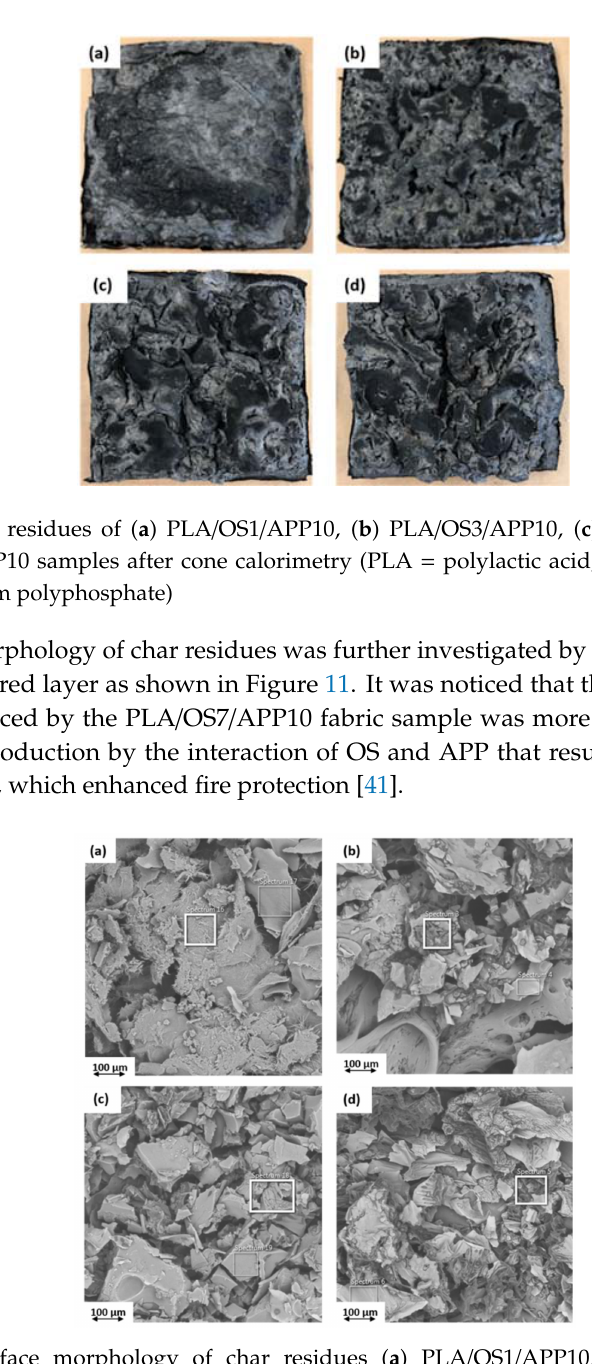
Figure 11. Surface morphology of char residues ( a ) PLA / OS1 / APP10, ( b ) PLA / OS3 / APP10, ( c ) PLA / OS5 / APP10 and ( d ) PLA / OS7 / APP10 (PLA = polylactic acid; OS = oxidized starch; APP = ammonium polyphosphate)